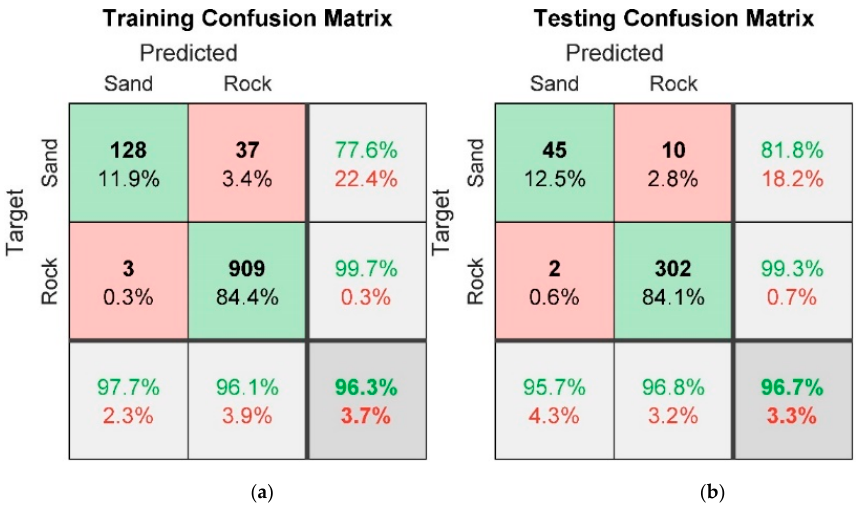
Figure 8. Confusion matrix for training ( a ) and testing ( b ) of the terrain classifier.